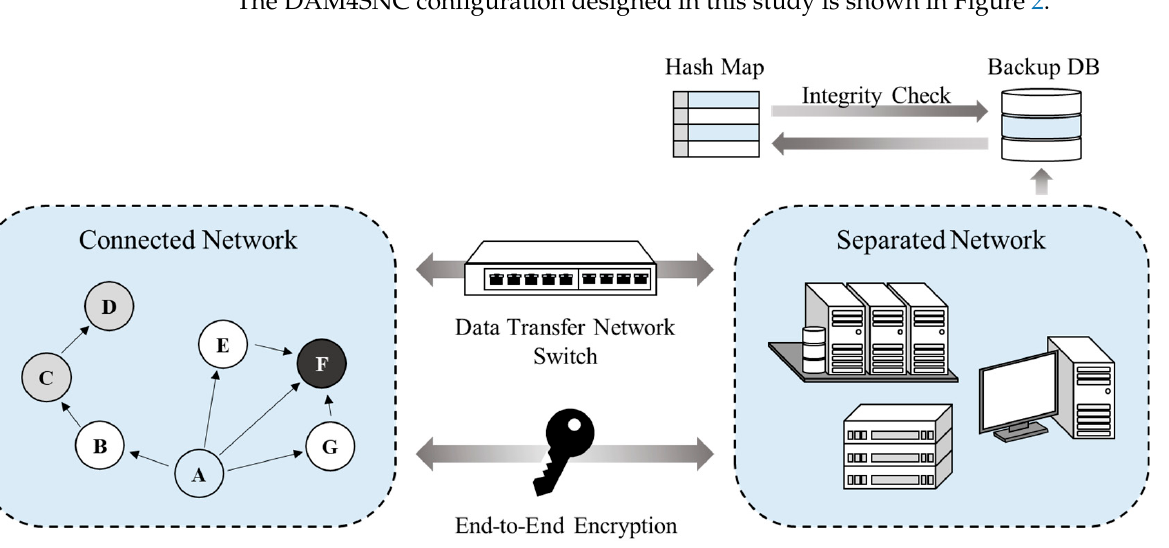
Figure 2. Structure of DAM4SNC.